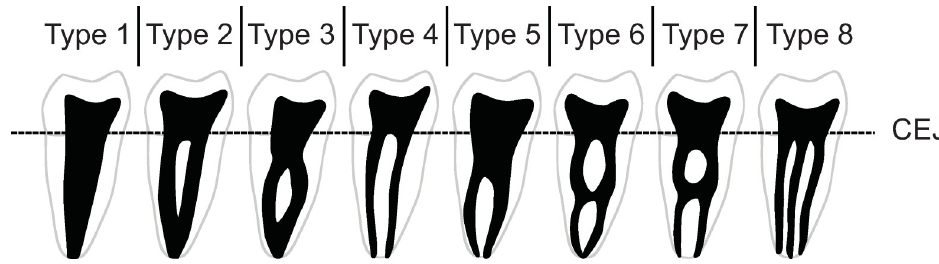
Fig 5. Vertucci’s widely used canal classification system. Root and canal number do not always conform to one another. Black area represents pulp chambers and various canal configurations [55].